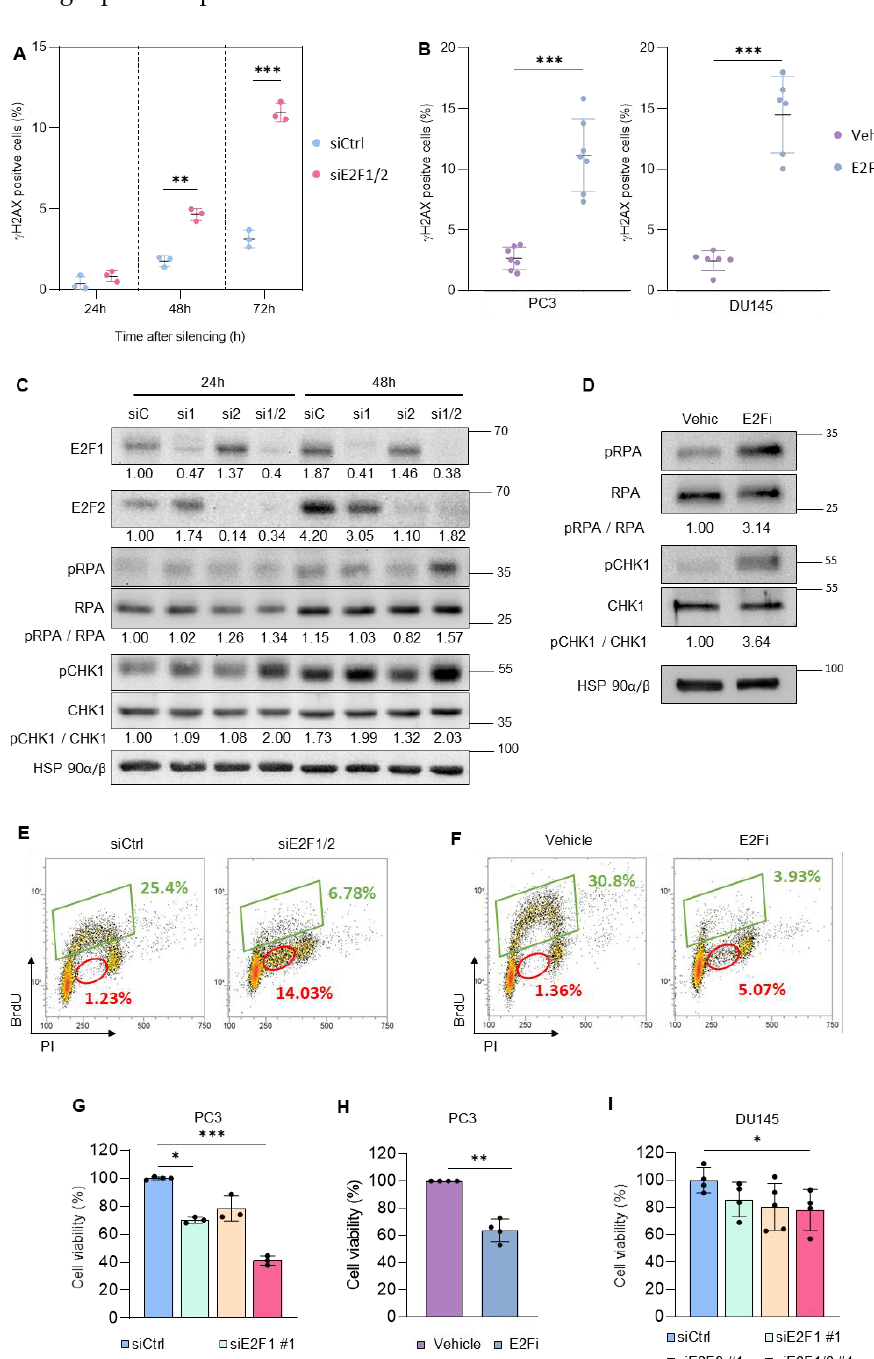
Figure 1. Genetic or chemical inhibition of E2F1/2 induces replication stress and compromises cellular viability. ( A ) Percentage of γ H2AX-positive cells at the indicated time points after transfection with siCtrl or siE2F1/2#1. Data shows the average ±SD from 3 independent experiments. ( B ) Percentage of γ H2AX-positive cells 24h after treatment with E2Fi in PC3 (20 µM, left panel) and DU145 cells (40 µM, right panel). In PC3 cells, data show the average ±SD from 7 independent experiments. In DU145 cells, data show the average ±SD from 6 independent experiments. ( C ) Representative Western blot analysis of E2Fs and several replication stress response activation markers in extracts prepared from PC3 cells 24 or 48h after transfection with siCtrl (sC), siE2F1#1 (si1), siE2F2#1 (si2), or siE2F1/2#1 (si1/2). HSP90 was used as loading control. Densitometric values were used to calcu- late phospho-to-total protein ratios, expressed as fold-over 24 h siCtrl sample. ( D ) Representative Western blot analysis of RPA and CHK1 in extracts prepared from PC3 cells 8h after treatment with